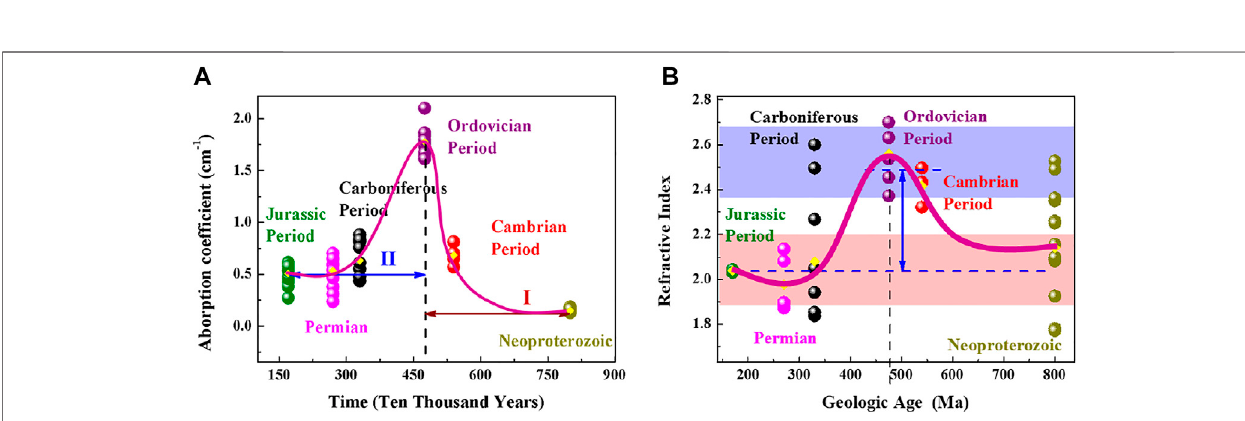
Frontiers in Physics |